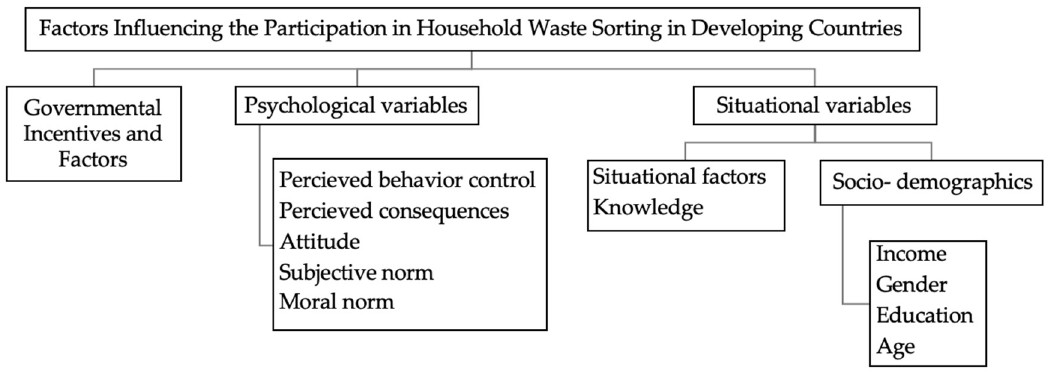
Figure 2. Identified variables and factors that influence the participation in household waste sorting in developing countries.